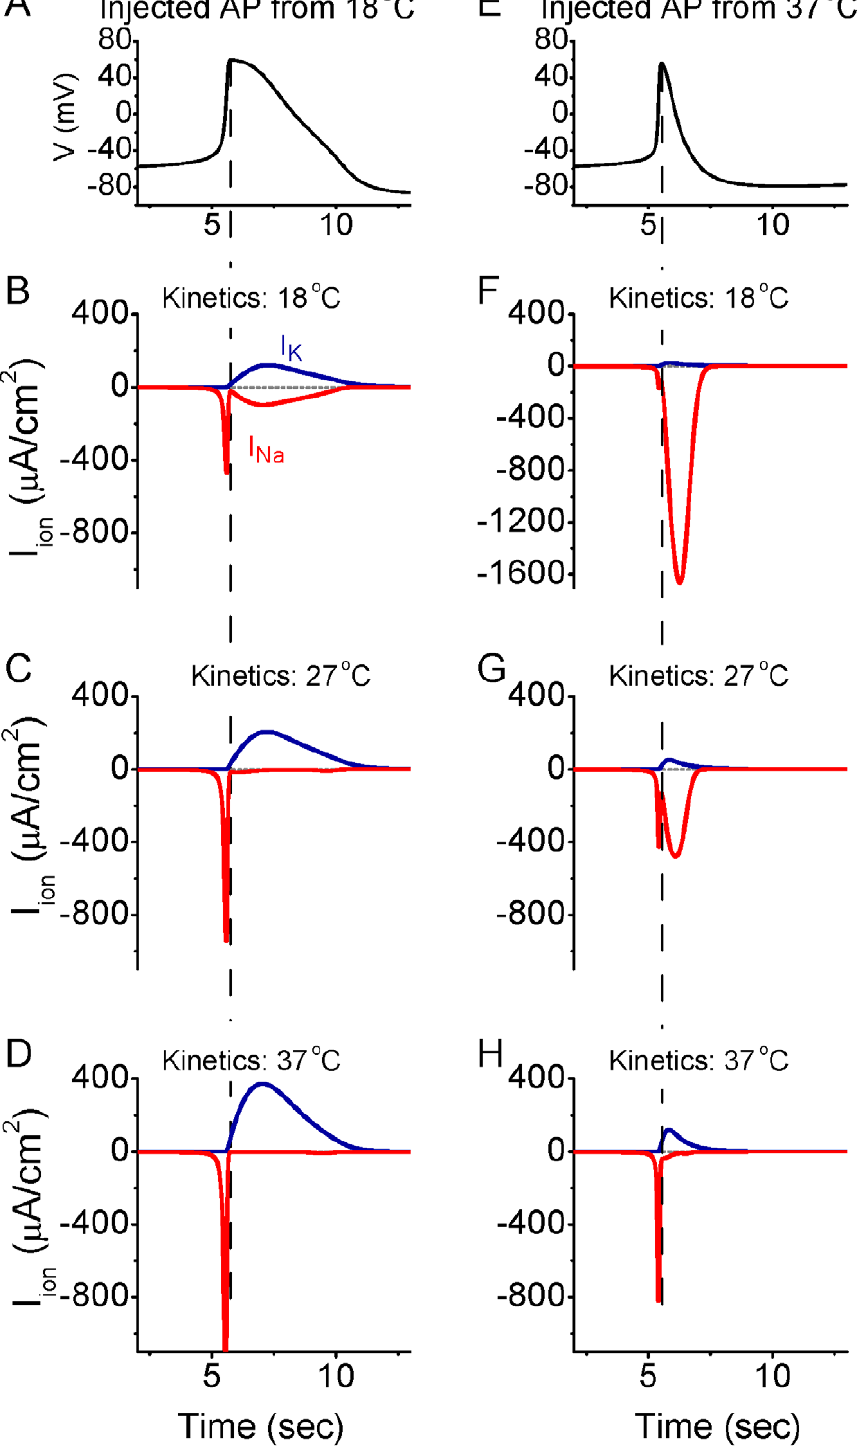
Figure 2. Changes in action potential shape do not explain the decrease in Na + entry and Na + /K + current overlap with increases in temperature. A. Action potential waveform occurring in the model axon at 18 u C. B. Currents obtained from the model when the action potential in (A) was injected into the model, using ionic current kinetics obtained at 18 u C. This result is the same as Figure 1B, 18 u C. C–D. Running the model through the action potential waveform of (A), but with the channel kinetics of 27 u C (C) or 37 u C (D) results in a large decrease in Na + /K + channel overlap (cf. B). E. Action potential waveform occurring in the model axon at 37 u C. F. Injecting the action potential waveform in (E) into the model with Na + /K + kinetics appropriate for 18 u C results in a large inward Na + current during the falling phase of the action potential, which overlaps extensively with the outward K + current. G–H. Increasing the kinetics to those appropriate for 27 u C (G) and 37 u C (H) results in a large decrease in the overlap of Na + /K + currents and the near disappearance of the Na + current occurring during the falling phase of the spike (H). Dashed lines are aligned to